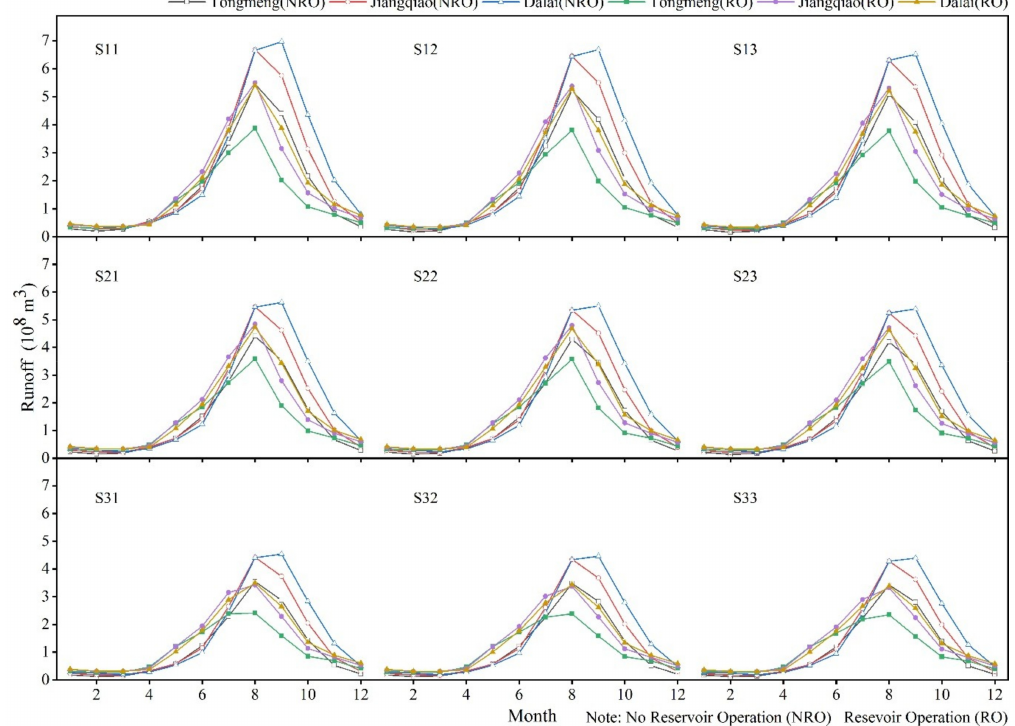
Figure 9. The mean monthly runo ff process of nine di ff erent